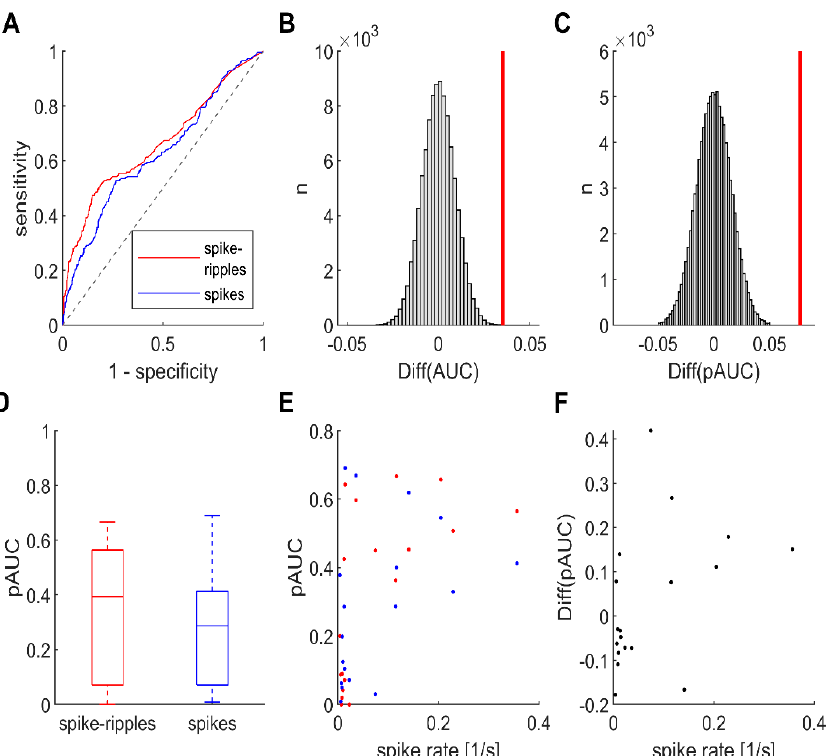
Figure 2. Interictal spike-ripples identify SOZ channels slightly but significantly better than spikes. ( A ) ROC curves, SOZ vs. non-SOZ classification, channels pooled across patients. The AUC for spike-ripples (red line, 0.664) was slightly higher than for all spikes (blue line, 0.628). ( B ) To investigate whether this difference was significant, we applied permutation-based hypothesis testing. The probability of obtaining an AUC difference that is as high as or higher than our empirically measured value (bold vertical line) by chance (grey bars represent surrogate data) was less than 5 % (two-tailed p < 0.001). ( C ) Same analysis for pAUC (between 85 and 100 % specificity), as applied in [32]. Again, spike ripples classified significantly better ( p < 0.001). ( D ) At the level of individual patients, there was no significant difference between the pAUC for spike-ripples and spikes ( p = 0.29). Note the broad range of values, reflecting that the SOZ could be nicely delineated in several patients, whereas performance was poor in others. ( E ) Both biomarkers classify better in patients with many interictal spikes. There was a significant correlation between our patients’ median spike rate and their pAUC, both for spike-ripples (red, p = 0.002) and spikes (blue, p = 0.02). Each dot corresponds to one patient. ( F ) Spike-ripples are a better classifier in patients with many spikes. There was a significant correlation between our patients’ median spike rate and their pAUC difference between spike-ripples and spikes ( p =